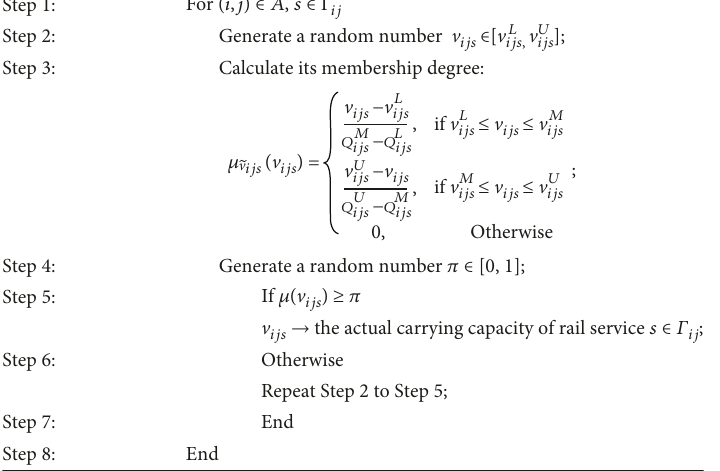
Figure 10: Fuzzy simulation process.